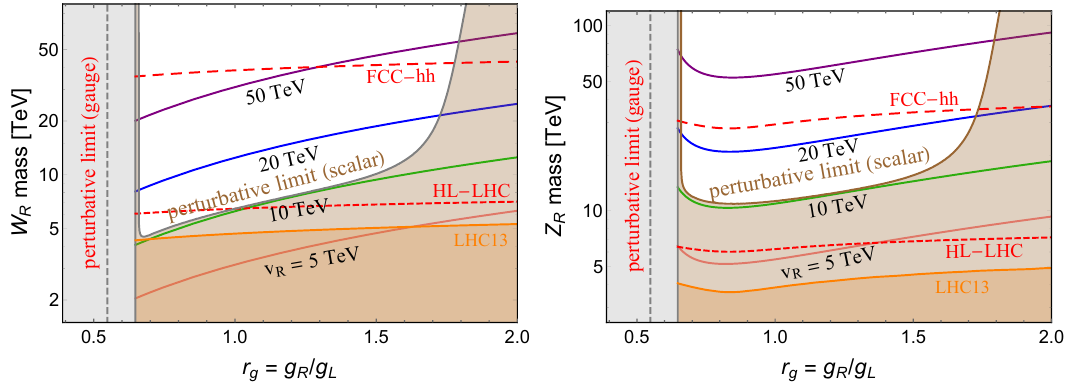
Figure 7 . Current LHC13 constraints on the W R (left) and Z R (right) masses in the minimal LRSM (shaded orange) as function of r g = g R =g L , and future prospects at the HL-LHC 14 TeV with an integrated luminosity of 3000 fb (cid:0) 1 (short-dashed red) and the 100 TeV collider FCC-hh with a luminosity of 30 ab (cid:0) 1 (long-dashed red). The pink, green, blue and purple lines are the W R =Z R mass with the RH scale v R = 5, 10, 20, 50 TeV, respectively. The shaded gray and brown regions are excluded respectively by the perturbative constraints from the gauge and scalar sectors up to the GUT scale. The dashed vertical line corresponds to the absolute theoretical bound in eq.